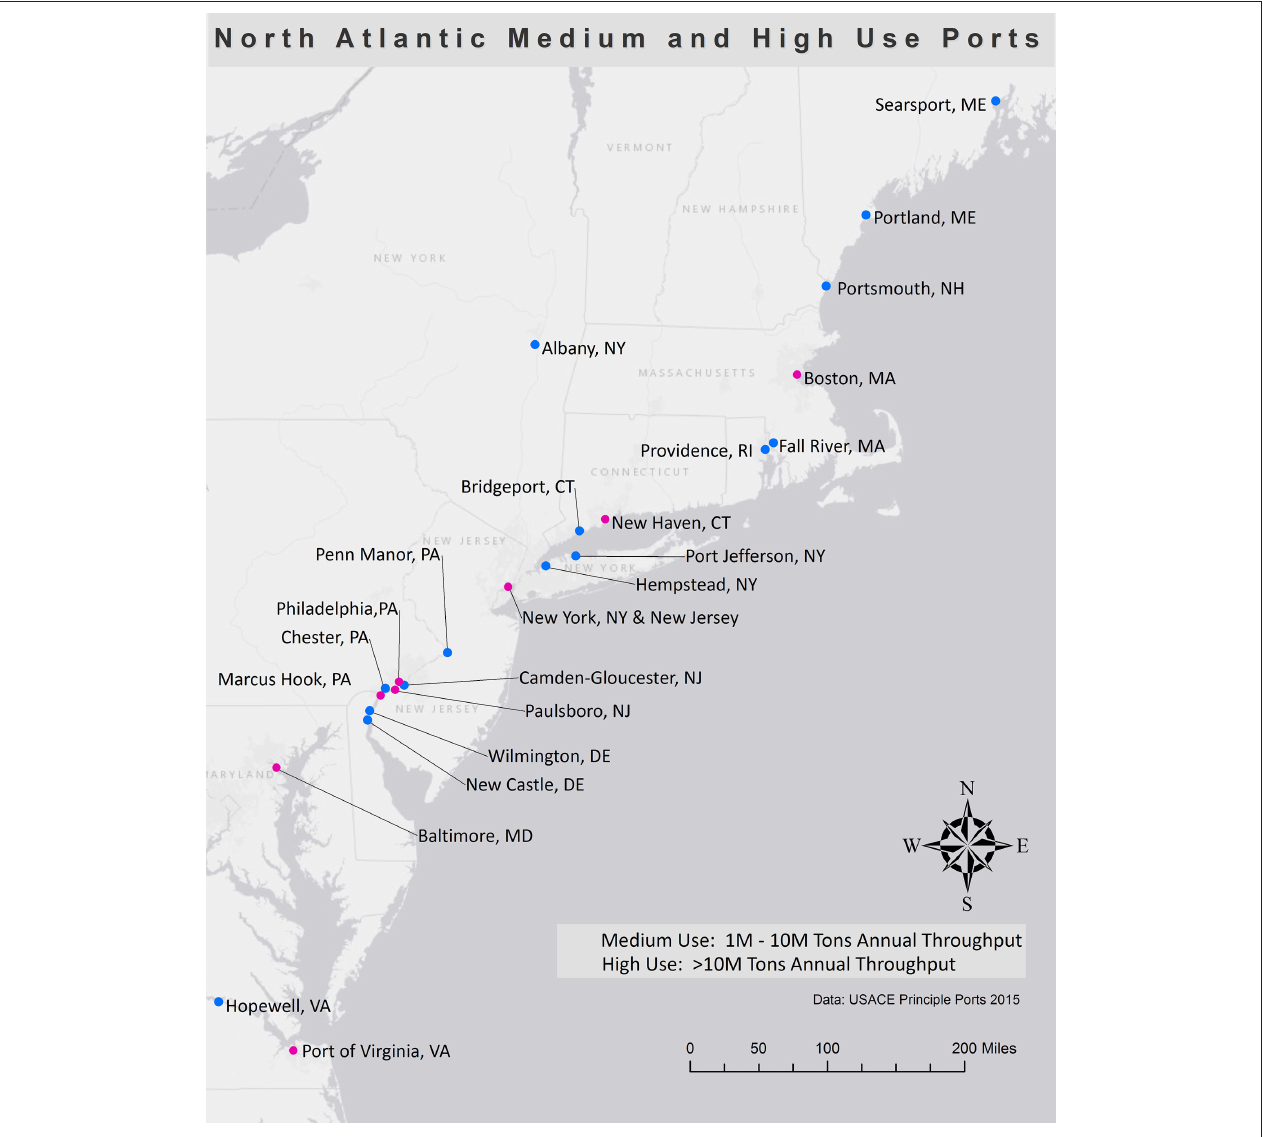
FIGURE 1 | The 22 medium-use (light blue dots) and high-use seaports (magenta dots).